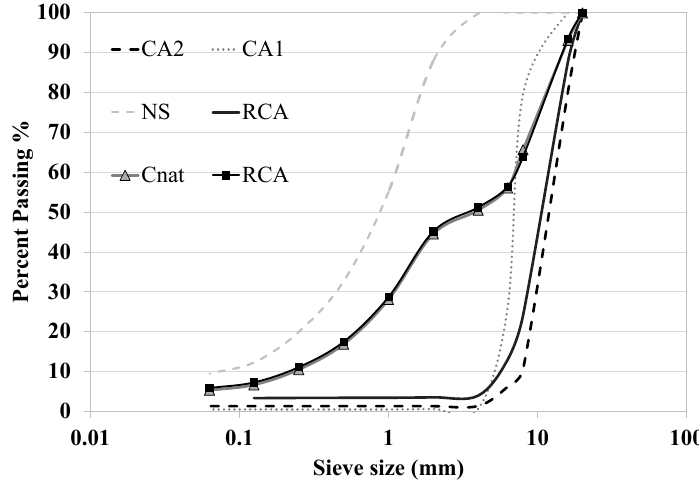
Figure 1. The grading distribution of all the aggregate fractions (NS, CA1, CA2 and RCA) and the corresponding mixtures used for concrete production with 100% of natural aggregates (C) and 50% coarse recycled concrete aggregates (RCA).